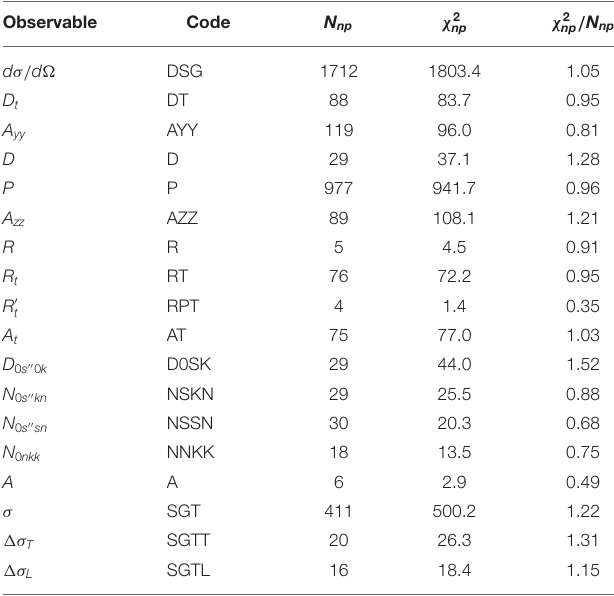
TABLE 3 | Contributions to the total χ 2 for different np observables [60,